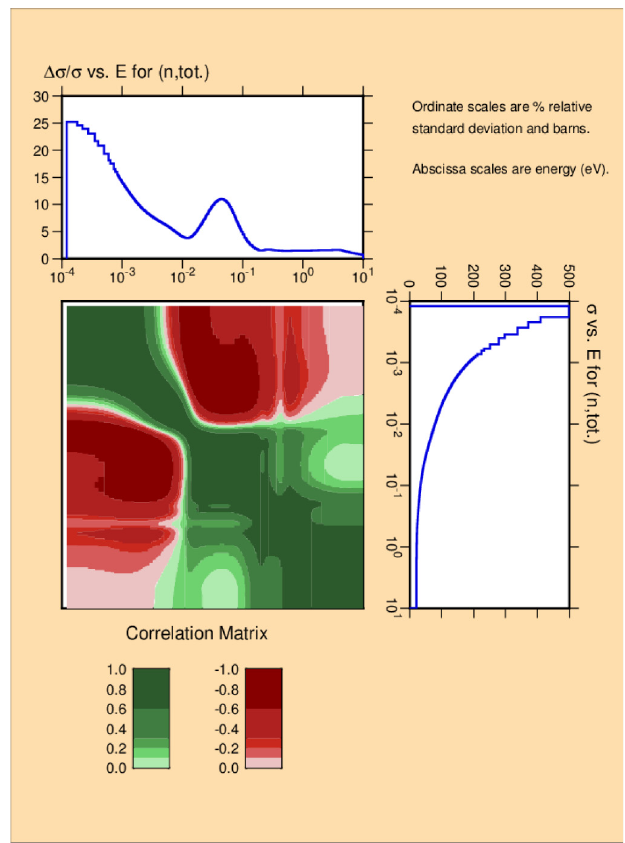
Fig. 10. Relative uncertainties and correlation matrix for the total cross section of H in H 2 O at 574K obtained with the Miscellaneous analysis mode of CONRAD by using the TSL parameters of